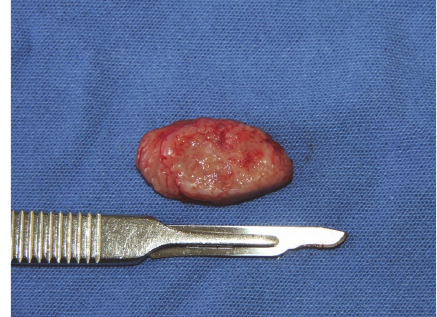
Figure 2: Excisional biopsy of the lesion.